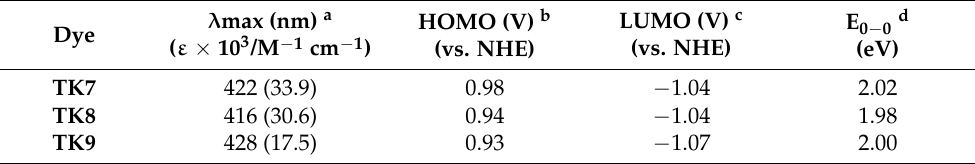
Figure 11. Absorption spectra of TK7 , TK8 and TK9 in CH 2 Cl 2 . Reprinted (adapted) with permission from ref. [103]. Copyright {2016} Elsevier. Table 9. Absorption and electrochemical data of TK7 , TK8 and TK9 .